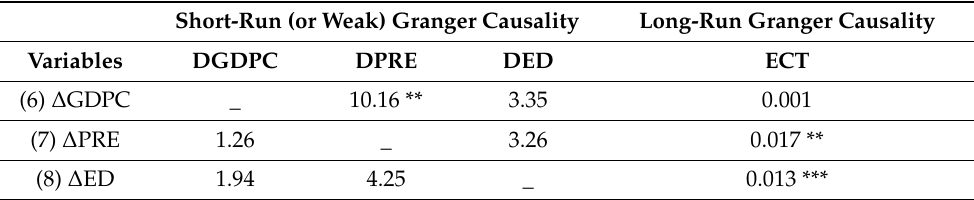
Table 10. Granger causality is based on the panel vector error correction model (PVECM). Short-Run (or Weak) Granger